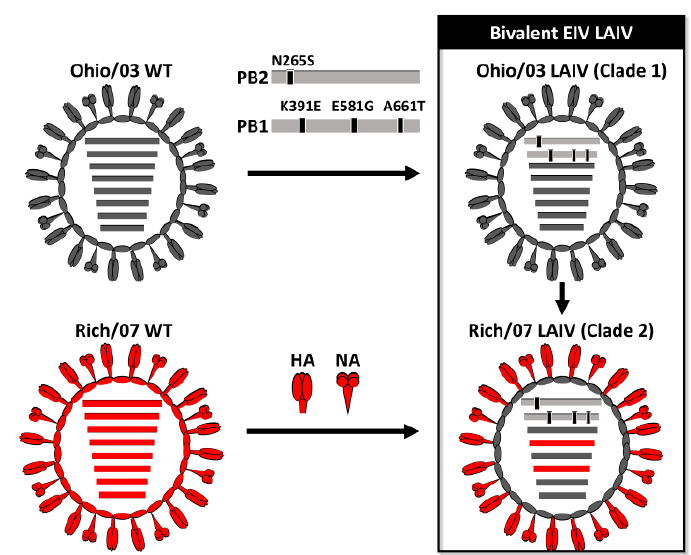
Figure 1. Schematic representation of the bivalent equine influenza virus (EIV) live-attenuated influenza vaccine (LAIV): To generate the clade 1 A/equine/Ohio/1/2003 H3N8 LAIV (Ohio/03 LAIV; top right), the temperature sensitive (ts), cold adapted (ca), and attenuated (att) mutations of the human A/Ann Arbor/6/60 H2N2 LAIV were introduced into the PB2 (N265S) and PB1 (K391E, E581G, and A661T) segments of A/equine/Ohio/1/2003 H3N8 wild-type (WT) (Ohio/03 WT; top left). Ohio/03 LAIV was used as a master donor virus (MDV) to generate clade 2 A/Richmond/1/2007 H3N8 LAIV (Rich/07 LAIV; bottom right), containing the six internal genes (PB2, PB1, PA, NP, M, and NS) from Ohio/03 LAIV and the hemagglutination assay (HA) and neuraminidase (NA) (red) of A/Equine/Richmond/1/2007 H3N8 WT (Rich/07 WT; bottom left). The bivalent EIV LAIV is made by combining Ohio/03 and Rich/07 monovalent LAIVs. Viruses 2019 , 11 , x FOR PEER REVIEW